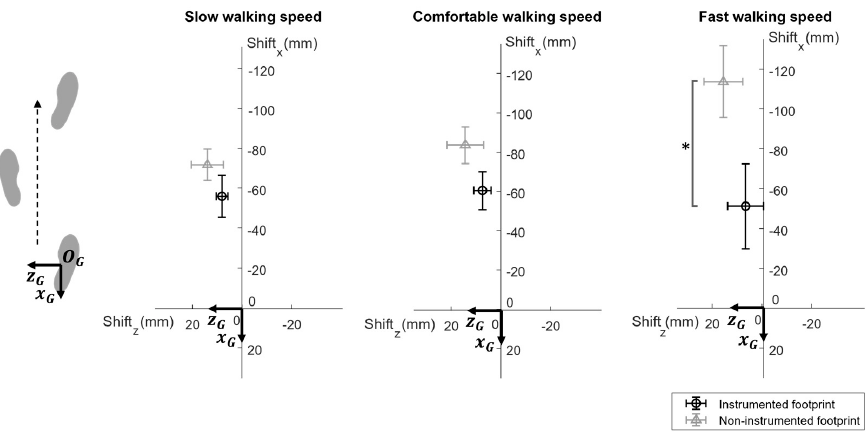
Figure 14. Mean plots with standard deviation bars for footprint shift x with respect to footprint shift z for the di ff erent walking speeds. The footprint shifts of the instrumented foot (black) and non-instrumented foot (grey) are the distances on the ground plane (x G -z G ) between sensor-based footprint centroids and the ones obtained with the stereophotogrammetric system. * statistically signi fi cant di ff erence at p < 0.05.